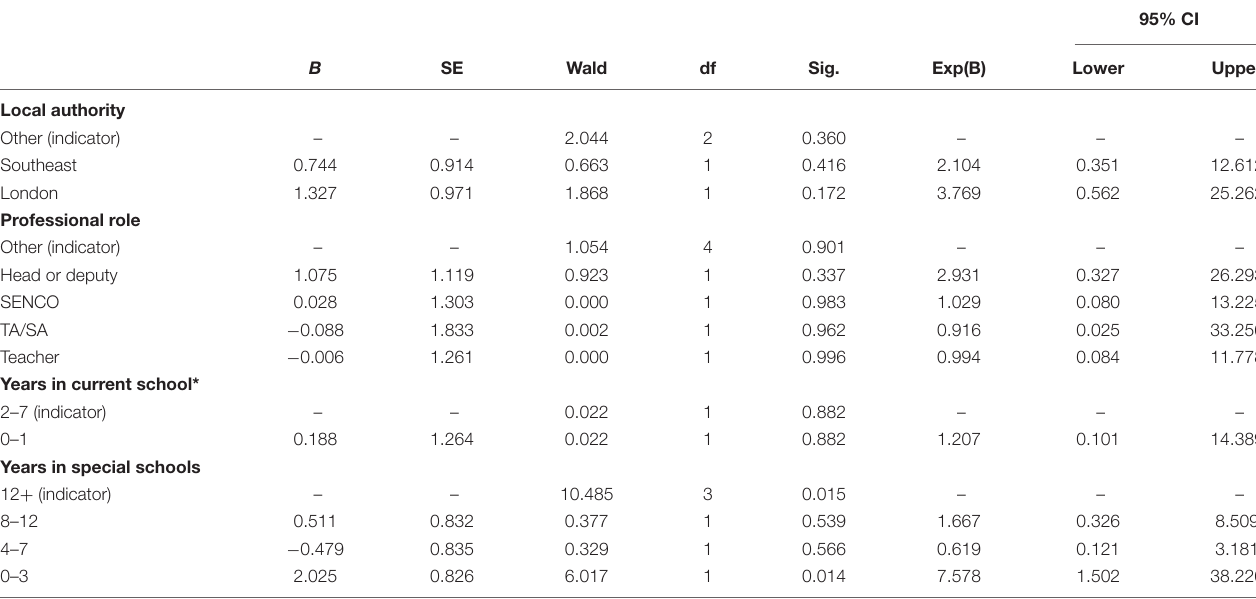
TABLE 3 | Regression coefficients regarding the effects of professional role, years of experience and geographical location of the setting on whether professionals would leave the job if they could (probability of responding that “perhaps” or